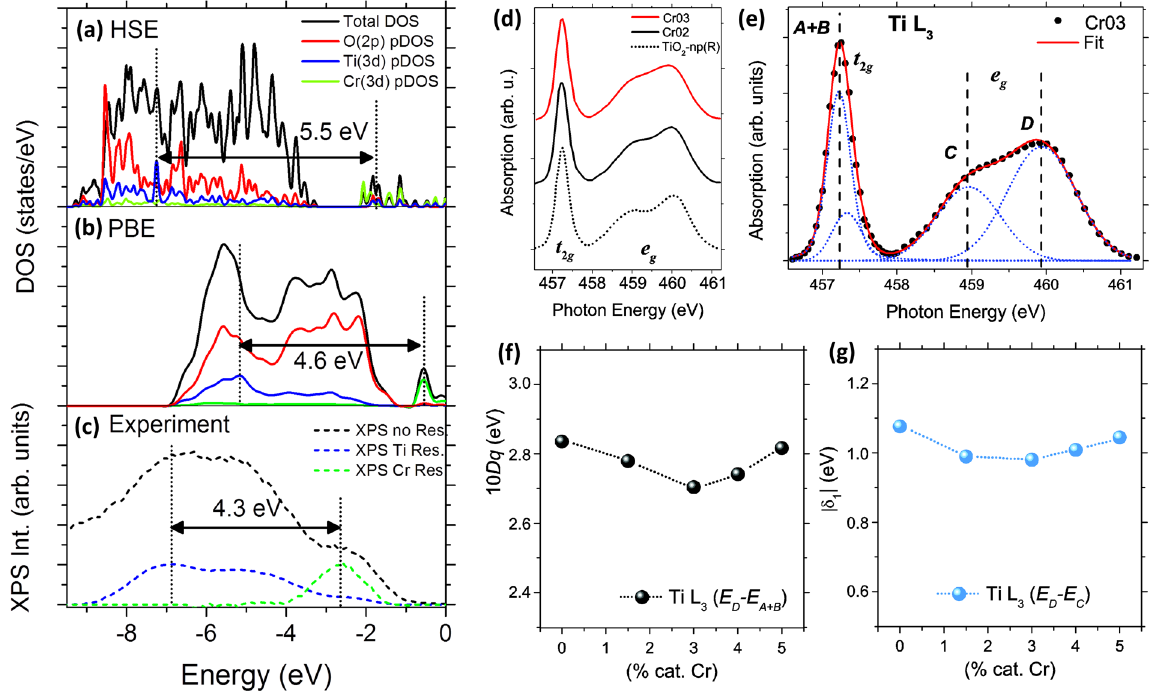
Figure 8. Comparison of the calculated DOS for 2Cr + V O defect calculated by ( a ) HSE functional, ( b ) PBE and ( c ) the experimental VB spectrum (Cr03 sample). The intensity of the on-resonance spectra in ( c ) are reduced to obtain similar features. ( d ) Ti-L 3 spectra from undoped and Cr doped TiO 2 samples (Cr02 and Cr03). ( e ) Example of a Gauss-Lorentz (G-L) deconvolution of the Ti-L 3 edge. ( f ) Estimation of 10 Dq parameter as a function of the Cr concentration from band deconvolution of Ti-L 3 edge. ( g ) Tetragonal distortion parameter | δ | as a function of the Cr